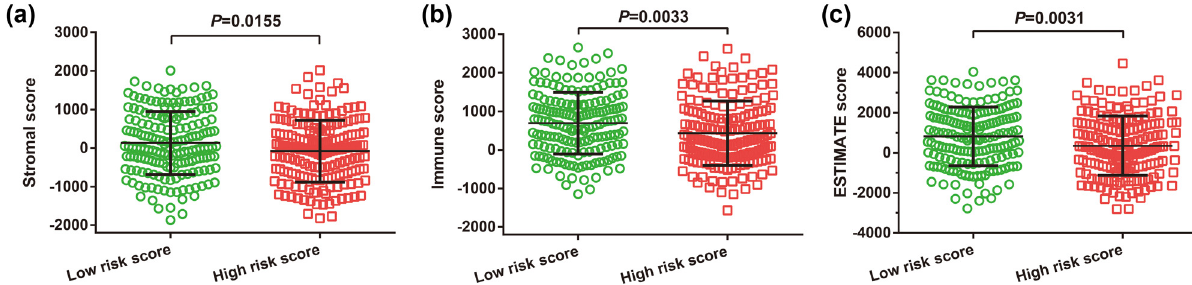
Figure 12: Results of tumor immune microenvironment analysis between low - and high - risk score phenotypes in GC: ( a ) Stromal score; ( b ) Immune score; and ( c ) ESTIMATE score.